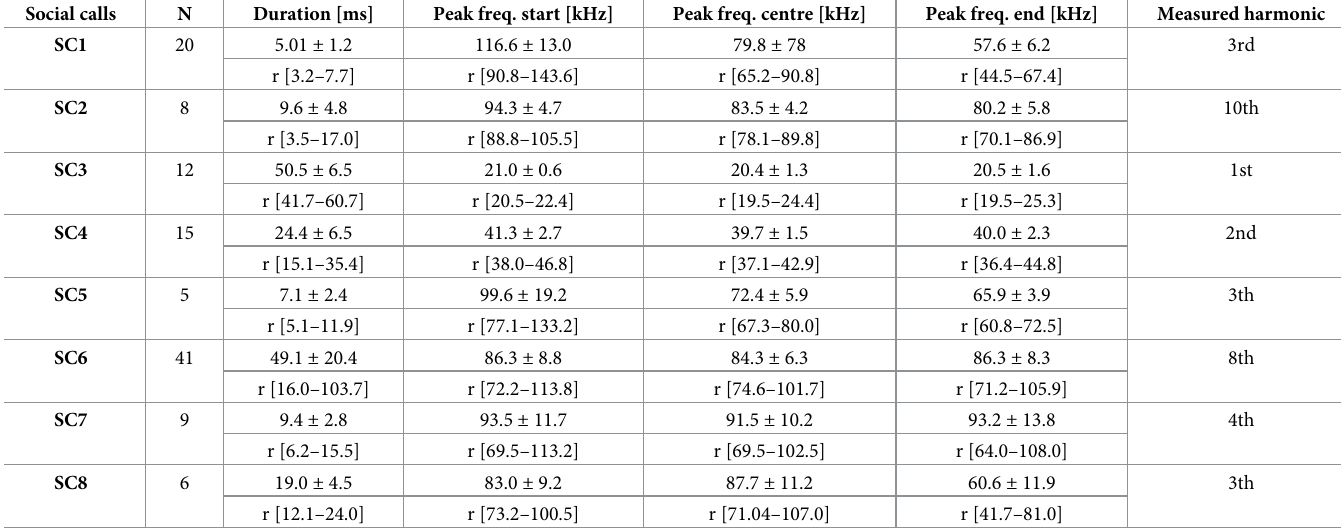
Table 3. Acoustic parameters of eight social call types.